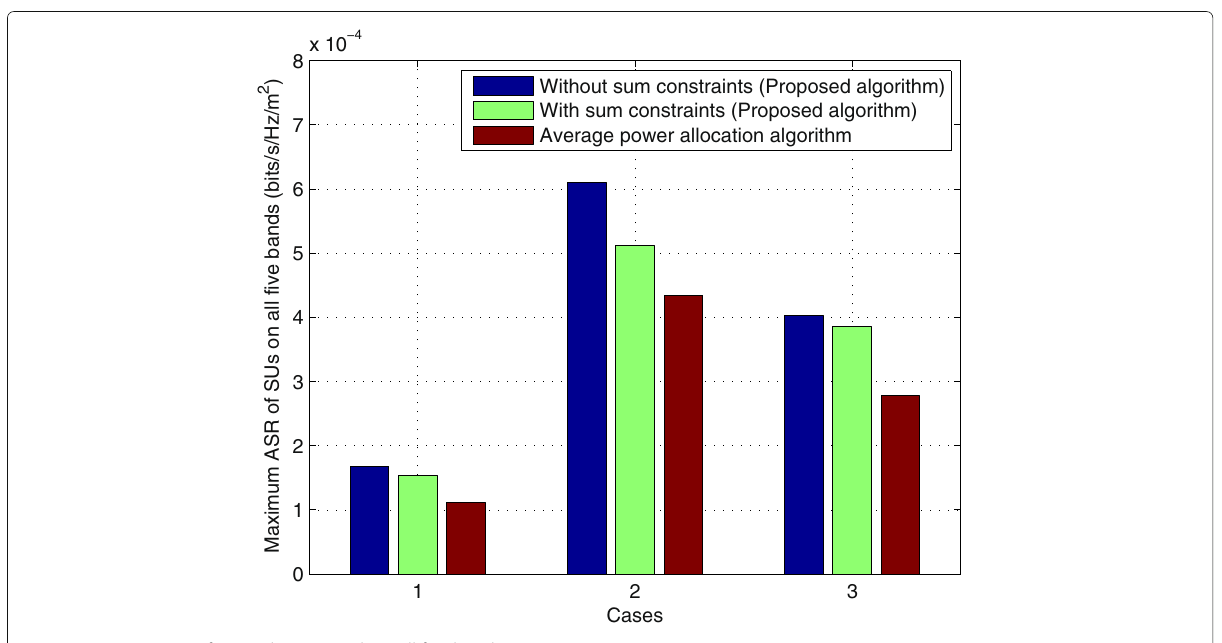
Fig. 8 Maximum ASR of secondary network on all five bands